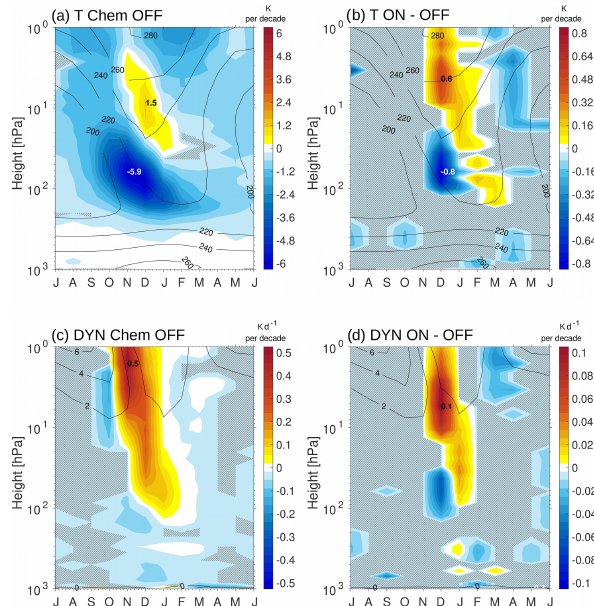
Figure 7. Polar cap (65–90 ◦ S) linear (a) temperature trend ( T ) in kelvin per decade and (c) dynamical heating rate trend (DYN) in kelvin per day per decade as function of height for the ensemble mean of Chem OFF for the time period 1969–1998 and the differ- ence to Chem ON (b, d) . The particular climatologies (contours) are represented for the same period with an interval of 20K (a, b) and 2Kd − 1 (c, d) . Statistically insignificant regions are hatched at the 5% level based on a Mann–Kendall